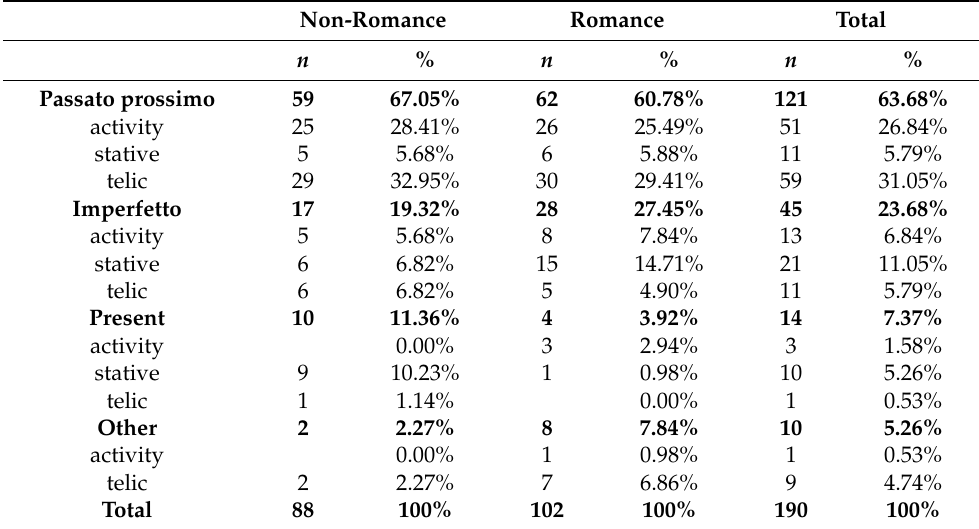
Table 5. Number of occurrences ( n ) and percentage (%) of tenses employed by low-proficiency learners in habitual contexts.